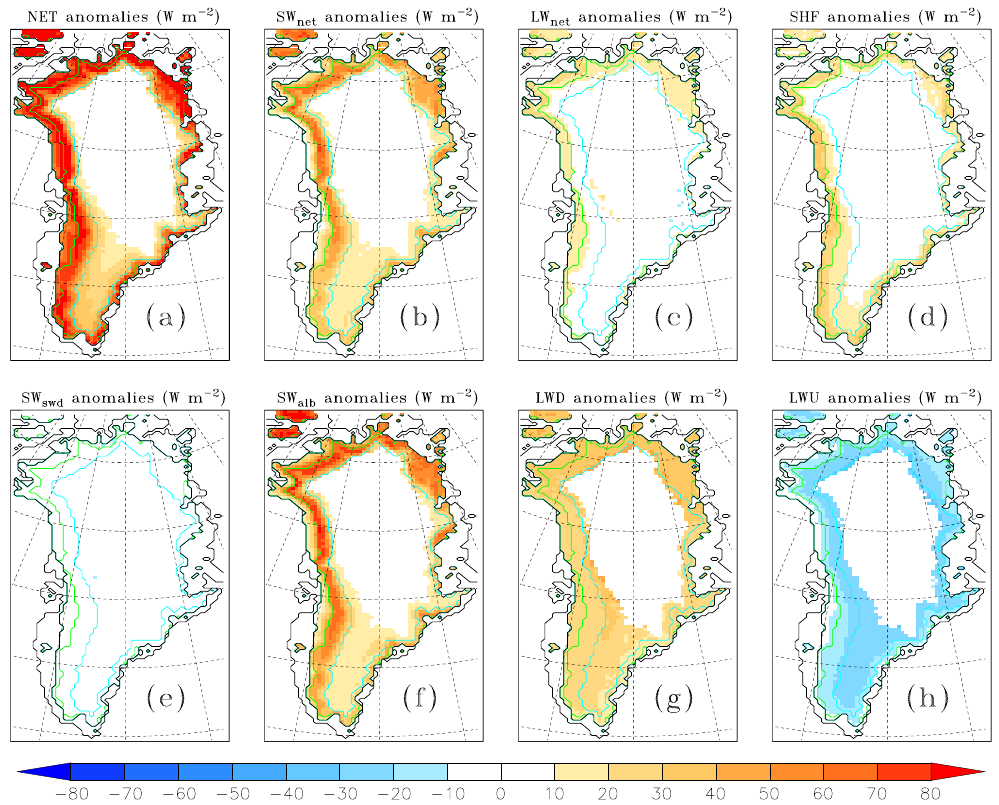
Fig. 6. (a) Net energy flux (NET) anomalies (Wm − 2 ) of the 2080–2099 MAR-CAN 85 simulation over the GrIS, compared to the 1980– 1999 MAR-CAN histo simulation, on the 1980–1999 MSK melt . The equilibrium line altitude (ELA) of the 1980–1999 MAR-CAN histo and 2080–2099 MAR-CAN 85 simulations are drawn in a solid green line and a solid blue line, respectively. (b–h) The same as (a) , but for the SEB component anomalies (Wm − 2